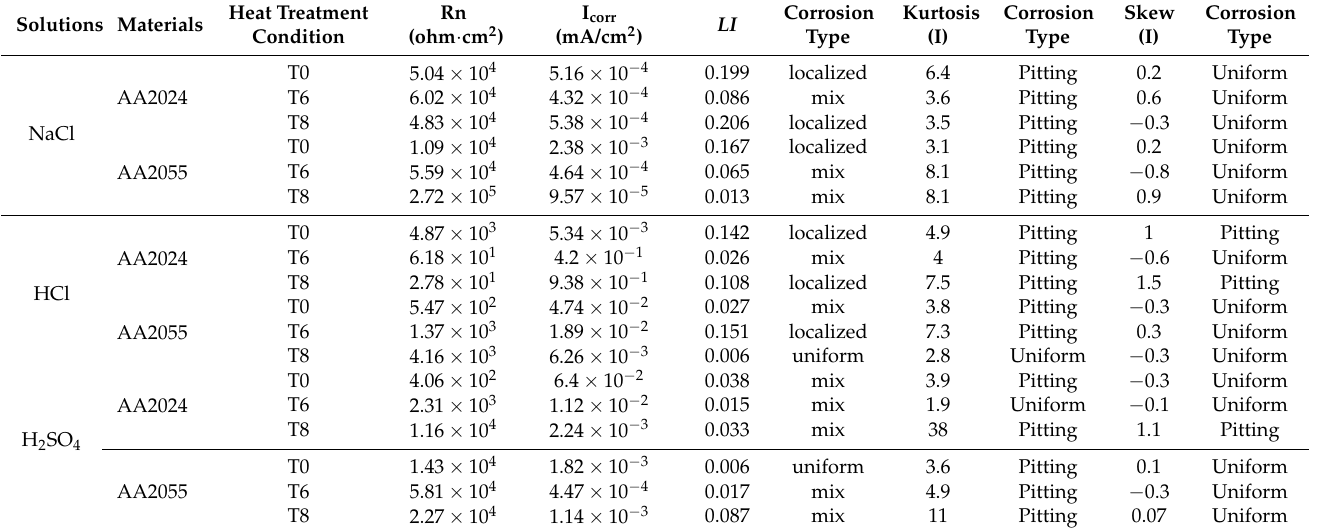
Table 5. Electrochemical noise parameters for aluminum alloys under heat treatment conditions and exposed to 3.5 wt. % NaCl, 1 wt. % HCl, and 1 wt. % H 2 SO 4